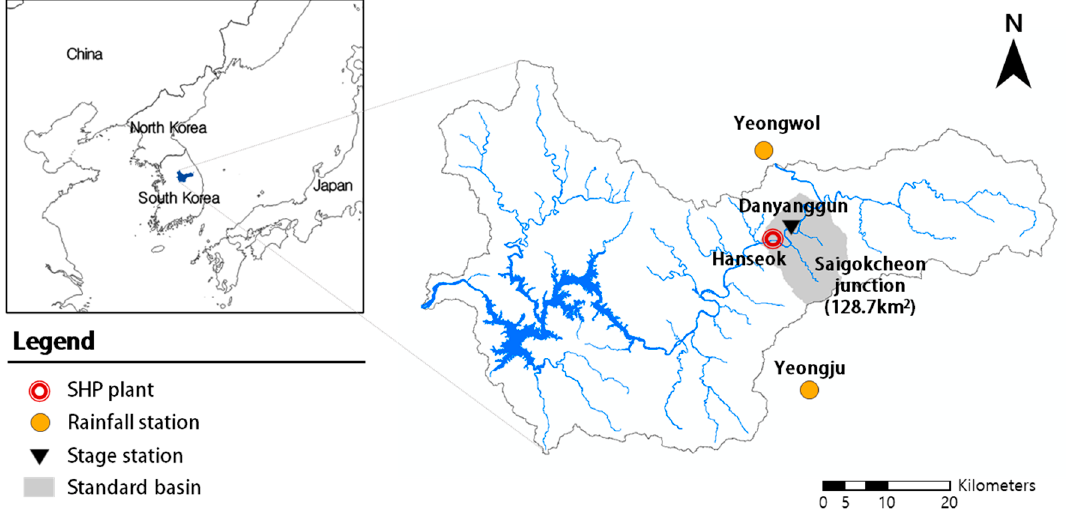
Figure 1. Location map of the target SHP plant, stations, and basin.